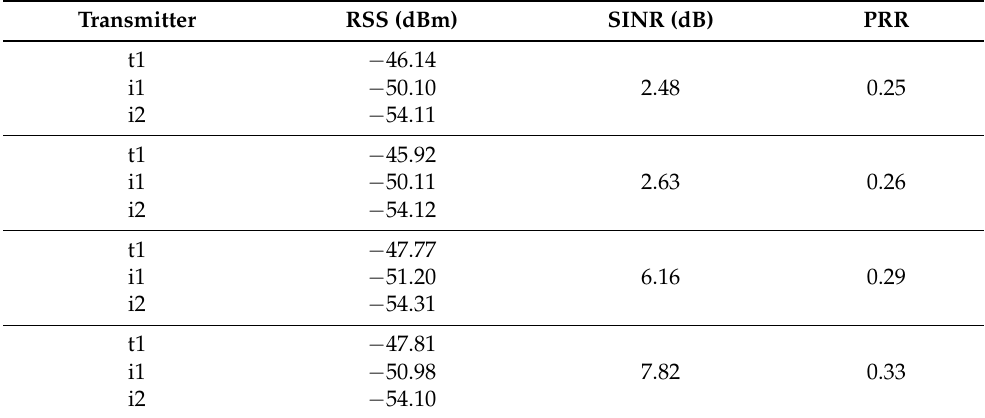
Table 3. Several experiments were performed to acquire the threshold in RSS from the sink node between the devices.